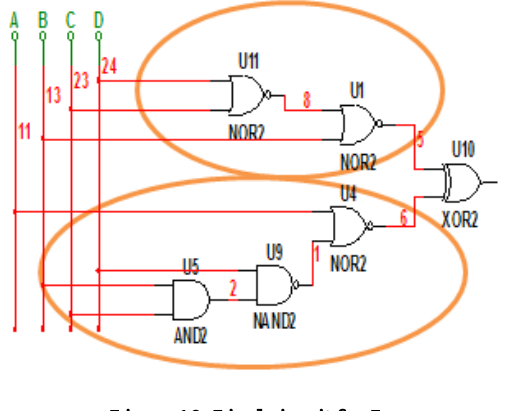
Figure 16. Final circuit for F